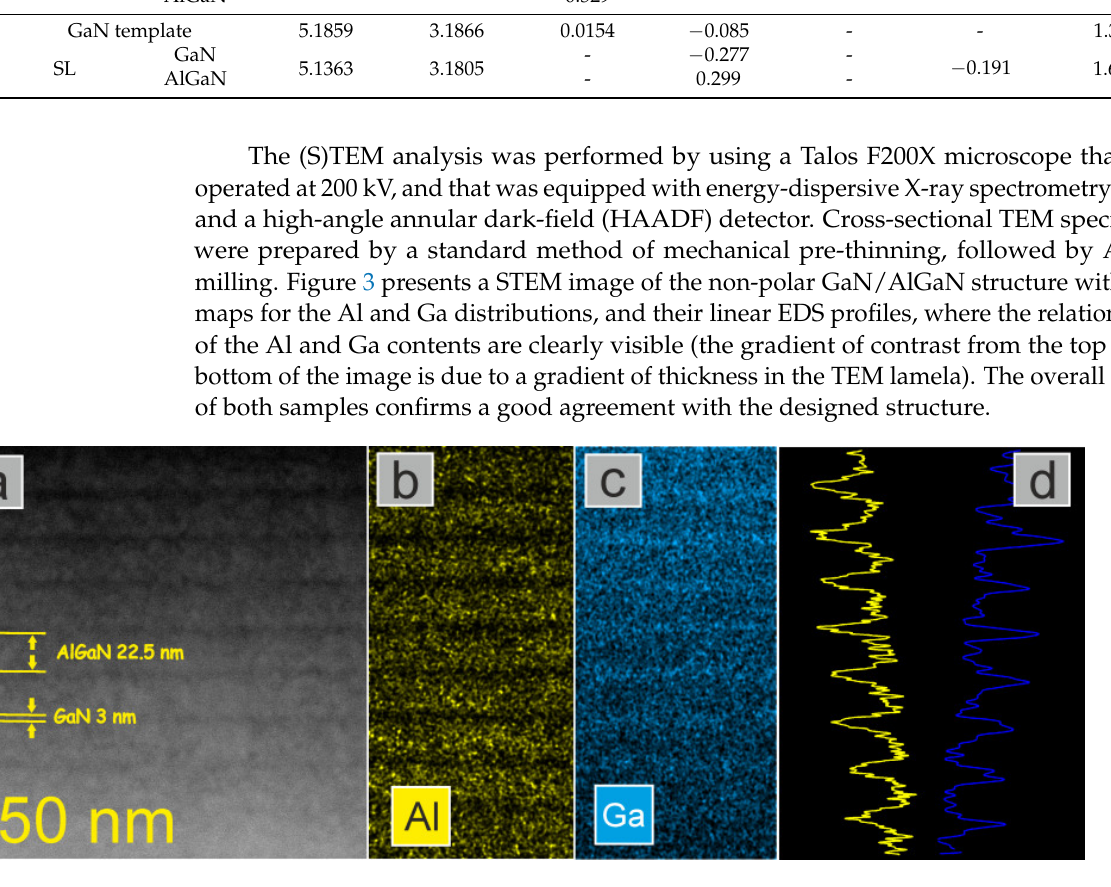
Figure 3. ( a ) Cross-sectional HAADF STEM image of the non-polar GaN/AlGaN MQWs, with EDS map for ( b ) Al, and ( c ) Ga distribution, and ( d ) the linear EDS profile.